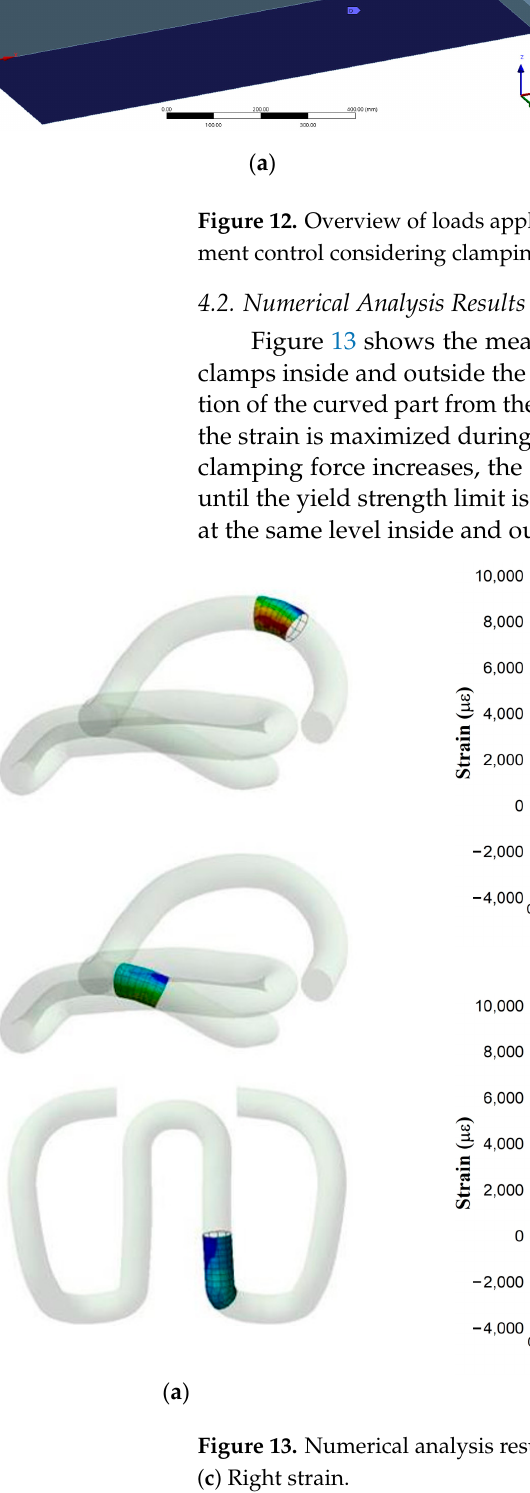
Figure 11. Conceptual diagram of the loading action of tension clamp. ( a ) Application of clamping force. ( b ) Application of curved track force.